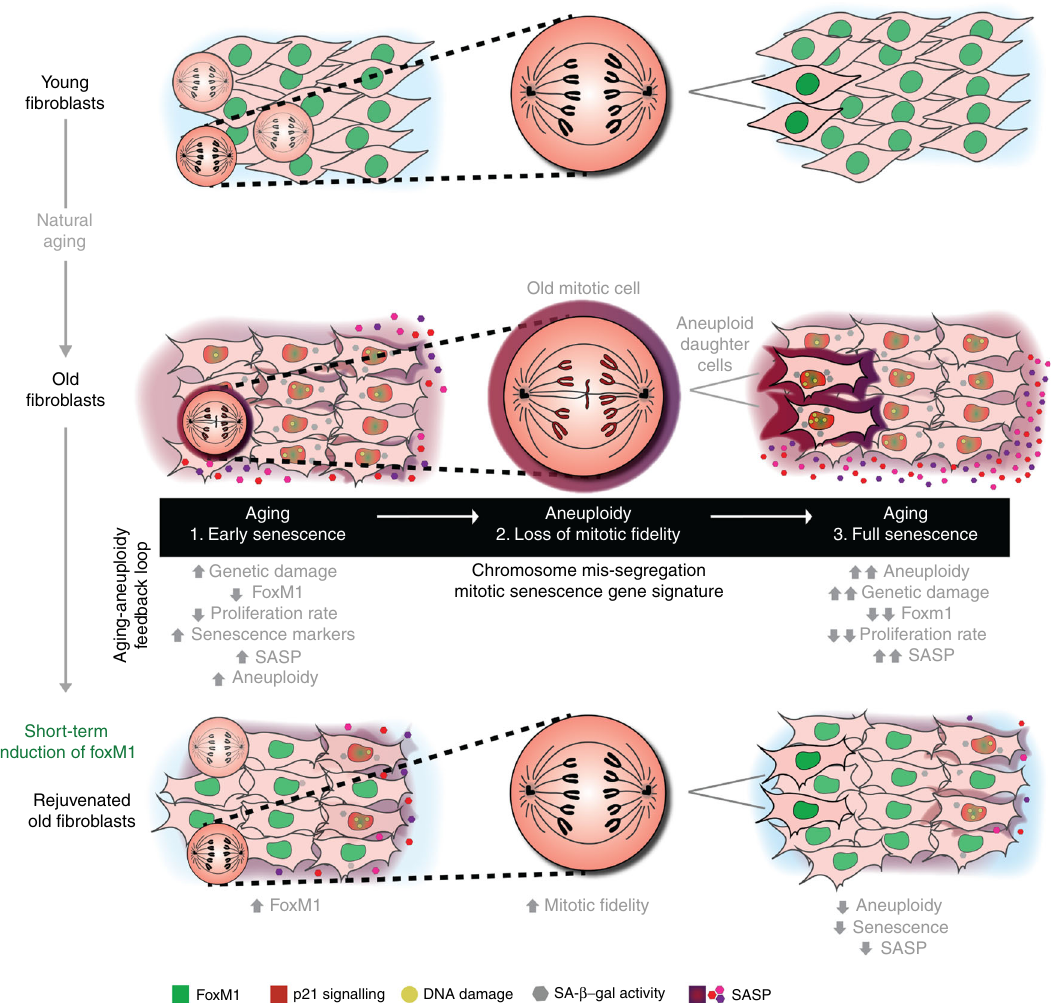
Fig. 8 Positive feedback loop between aging and aneuploidy. Model summarizing the molecular basis of age-associated mitotic decline and accumulation of senescent cells induced by aneuploidy. FoxM1 repression in aged dividing cells with senescence gene signature (1. early senescence) leads to general dysfunction of the mitotic machinery and increased chromosome mis-segregation rate (2. loss of mitotic fi delity). The aneuploid progeny stops proliferating exhibiting aggravated senescence phenotypes (3. full senescence) with pro-in fl ammatory impact in neighboring pre-senescent cells. FoxM1 induction in old cells improves mitotic fi tness and delays the accumulation of senescent